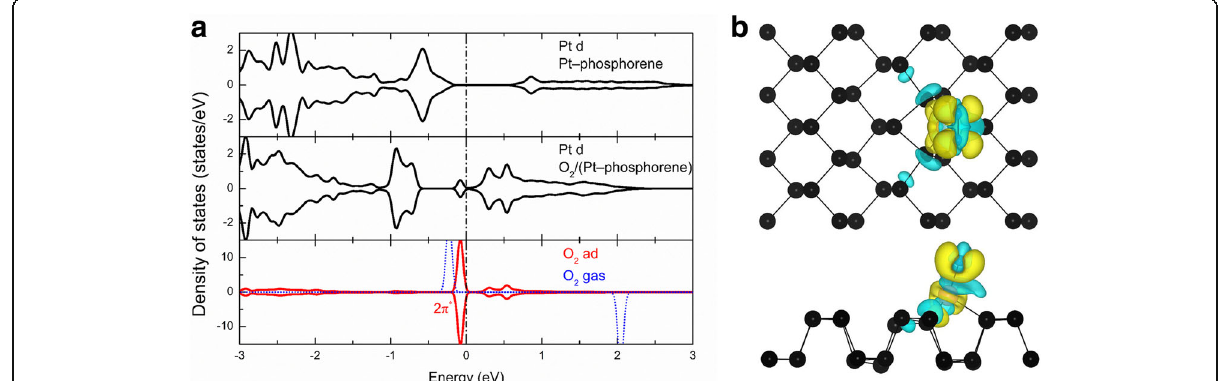
Fig. 4 a Local density of states (LDOS) of Pt and O 2 molecules in Pt-phosphorene and O 2 -Pt-phosphorene systems and gas phase O 2 , respectively. b Charge density difference in the O 2 -(Pt-phosphorene) system; the yellow region (i.e., +0.002 e/Å 3 ) and the cyan region (i.e., − 0.002 e/Å 3 ) correspond to the increase and the loss, respectively, of the electron density